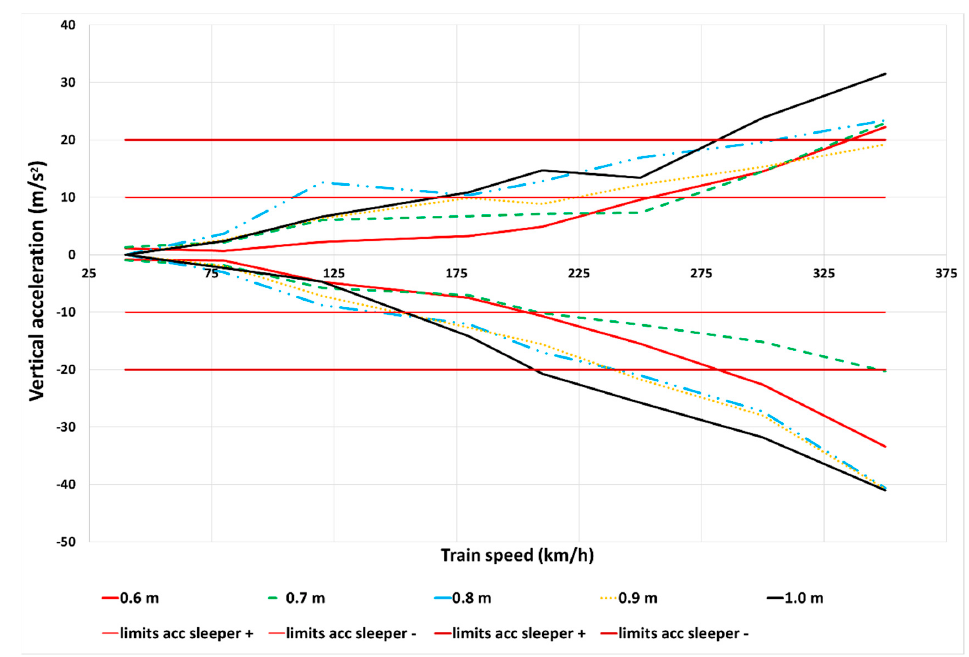
Figure 13. Limits for vertical acceleration on sleepers.